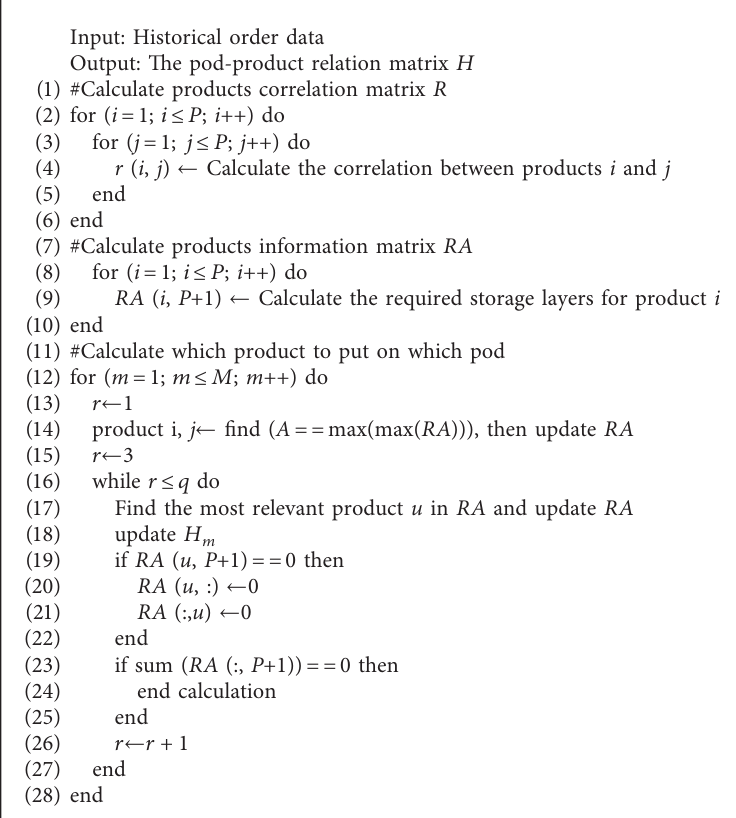
A LGORITHM 1: The heuristic algorithm of products